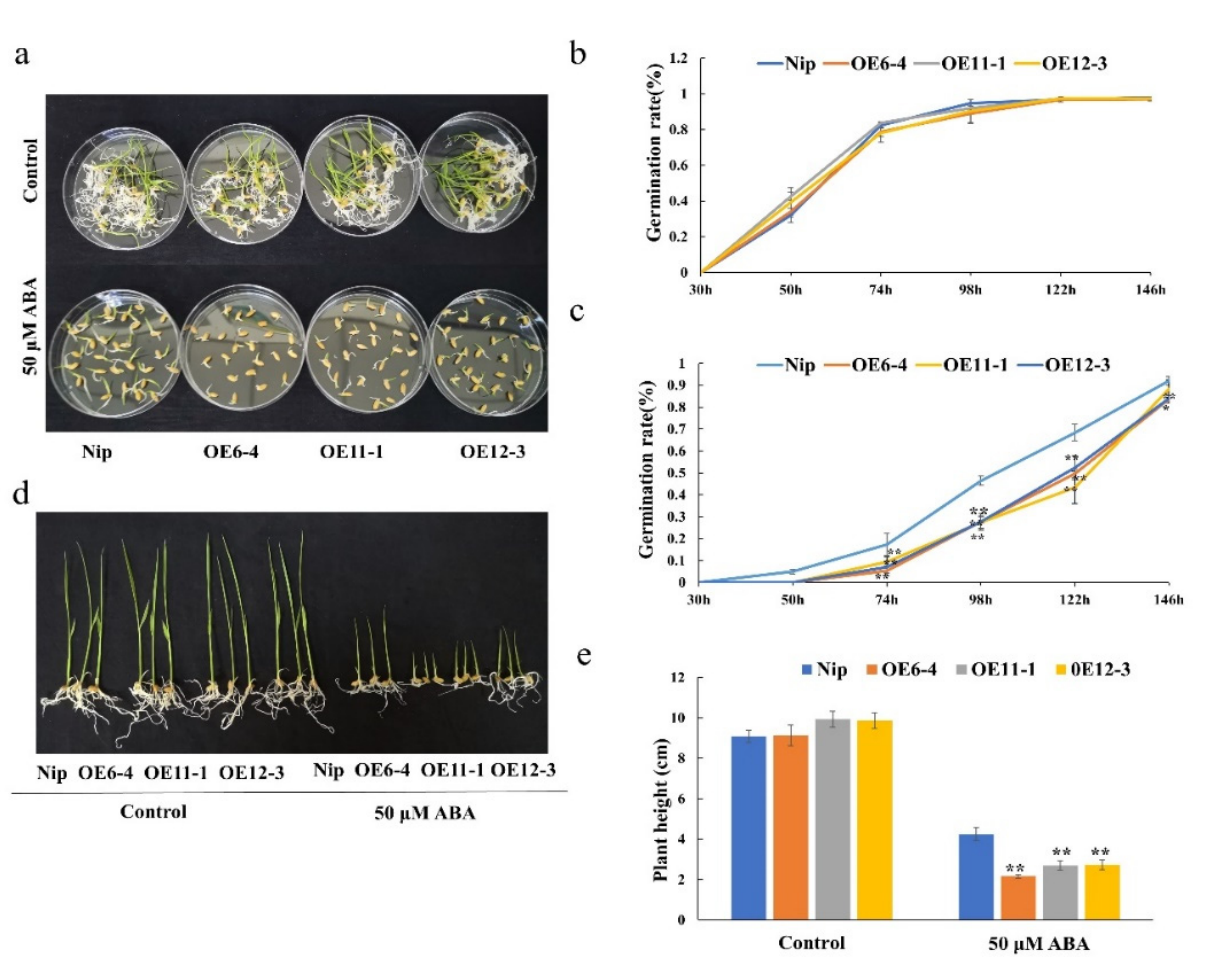
Figure 6. ABA treatment of OsMLP423 transgenic lines. ( a ) Germination of OsMLP423 overexpression lines treated with 50 µ M ABA for 7 days. ( b ) Line graph of germination rate of OsMLP423 overexpression plants in normal water culture for 7 days. ( c ) Line graph of germination rate of OsMLP423 overexpressing plants treated with 50 µ M ABA for 7 days. ( d ) OsMLP423 transgenic plants treated with 50 µ M ABA for 9 days. ( e ) Relative plant heights. Values are mean ± SE ( n = 3). Asterisks indicate significant differences between transgenic lines and WT (* p < 0.05, ** p < 0.01). n = 20 plants per treatment.